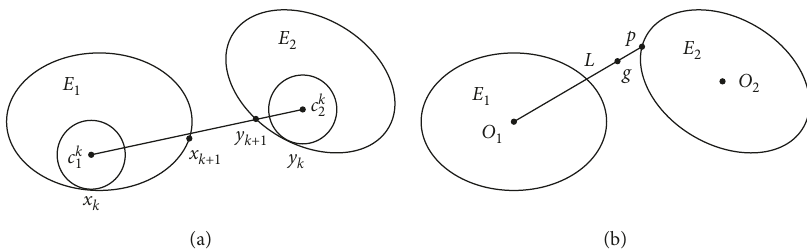
Figure 7: Diagram for judging the interference relationship between two